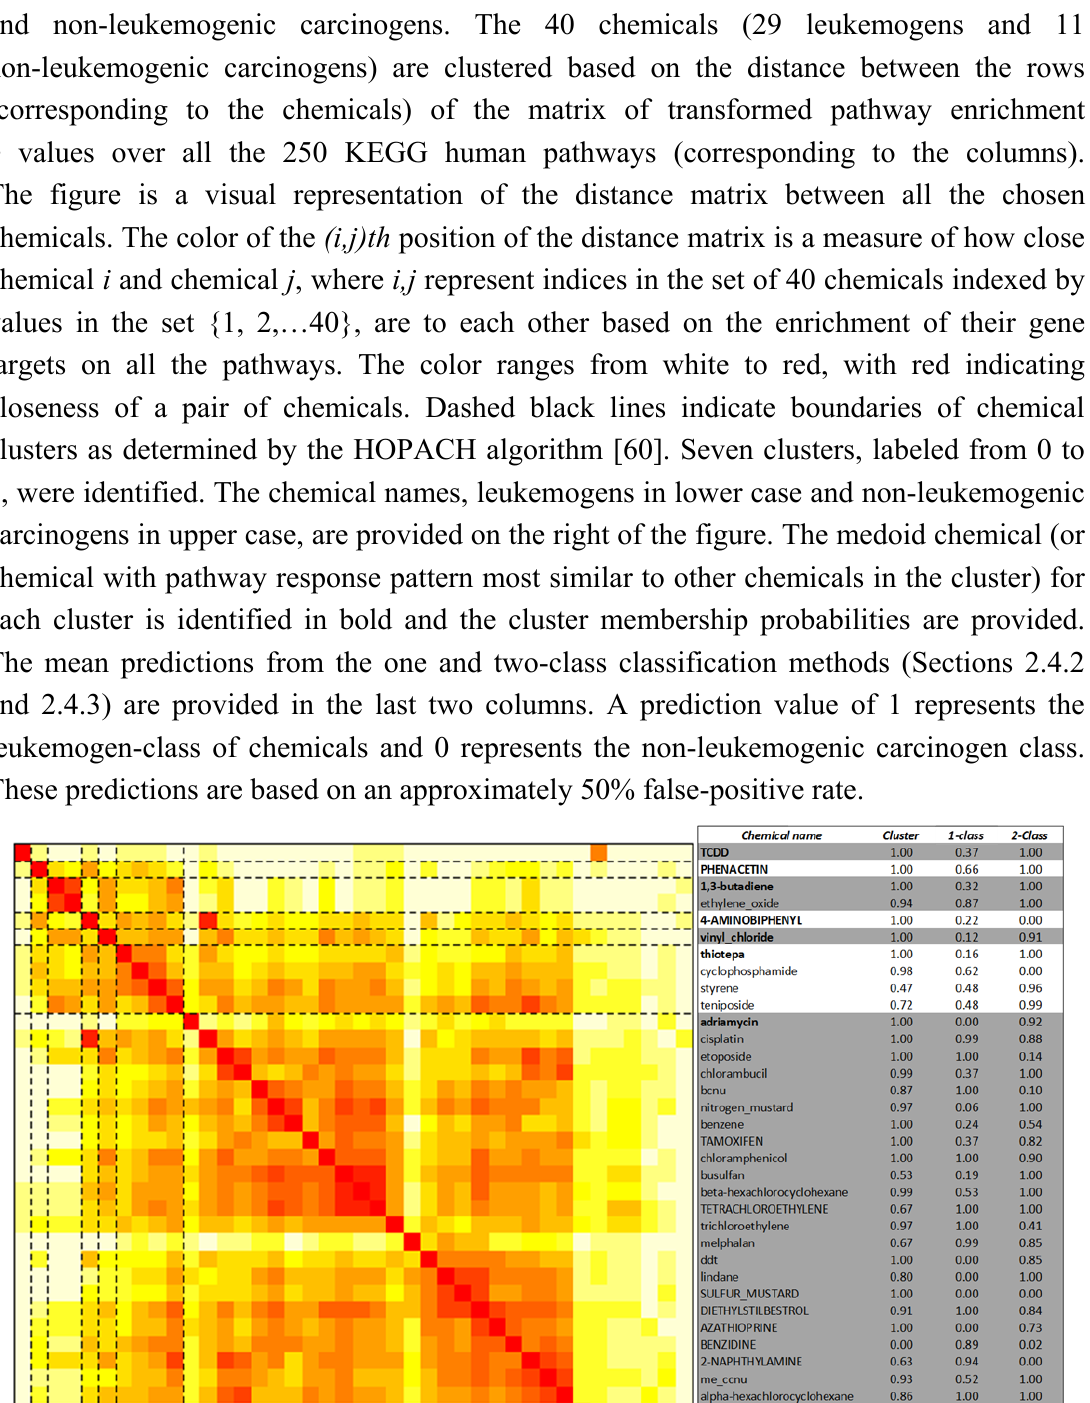
Figure 4. Unsupervised clustering and supervised classification of